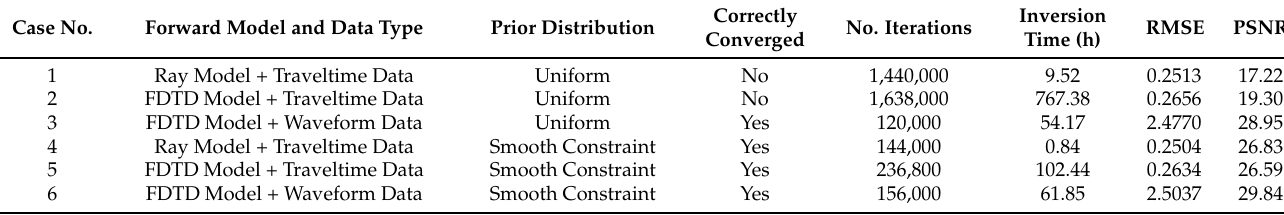
Figure 12. Posterior solutions of the Bayesian inversion with smooth model constraint using ( a – c ) the straight-ray model with first-arrival traveltime data, ( d – f ) FDTD model with first-arrival traveltime data, and ( g – i ) FDTD model with waveform data. The left and middle columns display the maximum a-posteriori (MAP) density and posterior mean solutions, respectively, whereas the right column presents the variance of the posterior solutions. Table 3. Summary of the Bayesian inversion